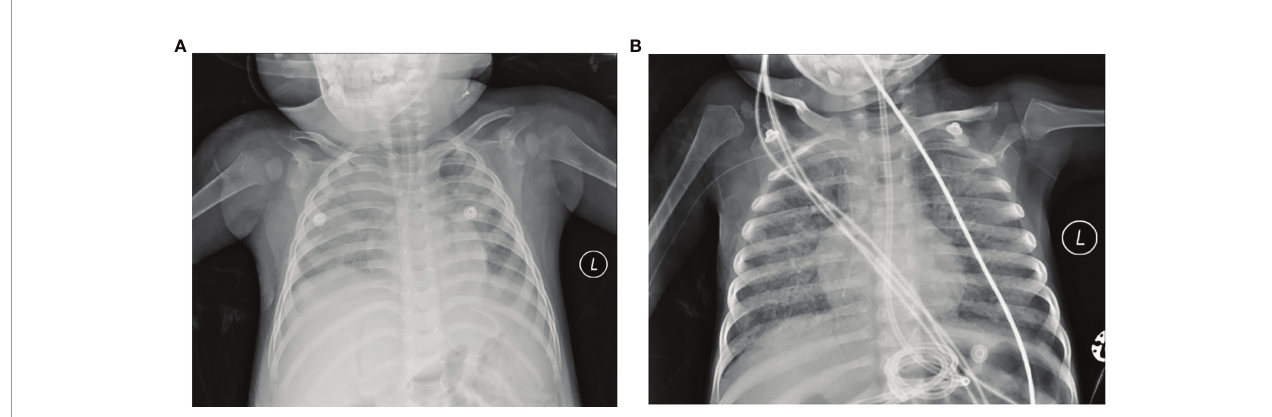
FIGURE 1 | Chest X-ray of the lungs from the acute phage of the two fatal cases. (A) Case 1. Acute phage of pneumonia revealed the texture of the two lungs as thickened and fuzzy, the light transmittance of the left lung is diffusely reduced, left diaphragm blurred, the light transmittance of the right lung unevenly reduced, patchy shadows shown in the right lung. (B) Case 2. The lung light transmittance was unevenly reduced, and multiple high-density shadows and small air bubble emphysema were seen in both lungs. Part of the bronchiectasis and part of the cavity were irregular, especially in the middle lobe of the right lung.